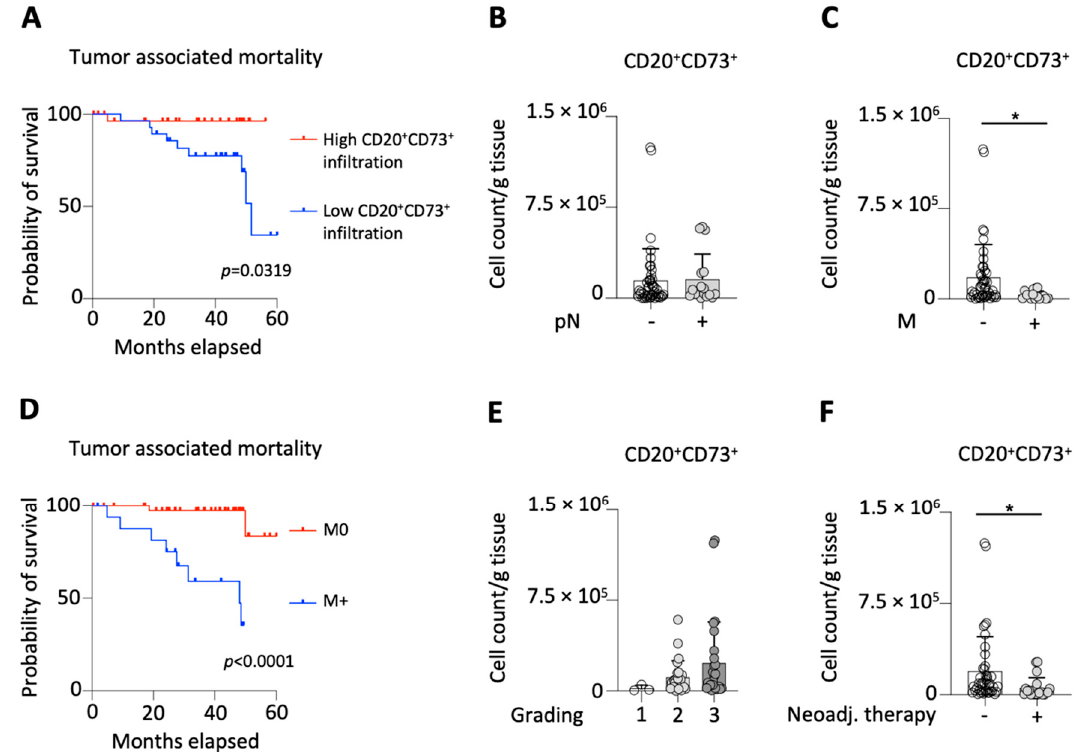
Figure 3. CD20 + CD73 + B-cell numbers from 62 patients were correlated with the following clinico- pathological parameters including: survival of patients ( A ), lymph node status ( B ), and the presence of distant metastasis ( C ); survival of localized was compared to metastasized tumors ( D ); cell count of CD20 + CD73 + B-cells were also correlated with the histological grading ( E ), and the status of neoadjuvant treatment ( F ); * = p < 0.05. Table 1. Clinicopathological characteristics of the patients grouped according the median cell count of CD20 + CD73 + B-cells into low ( n = 31) and high ( n = 31) infiltration.